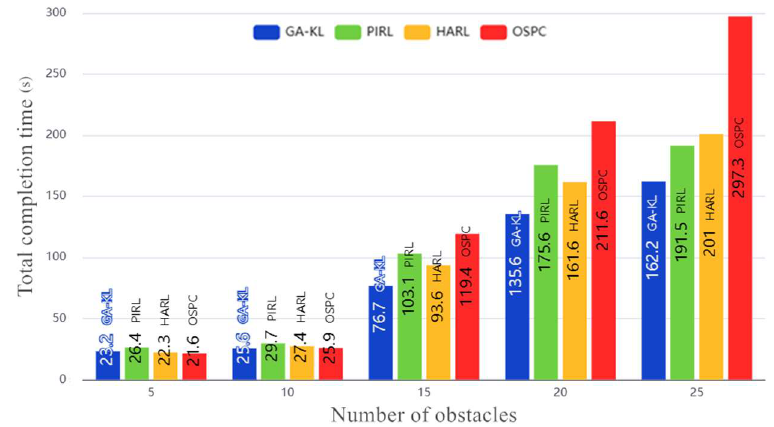
Figure 19. Comparison of total completion time.